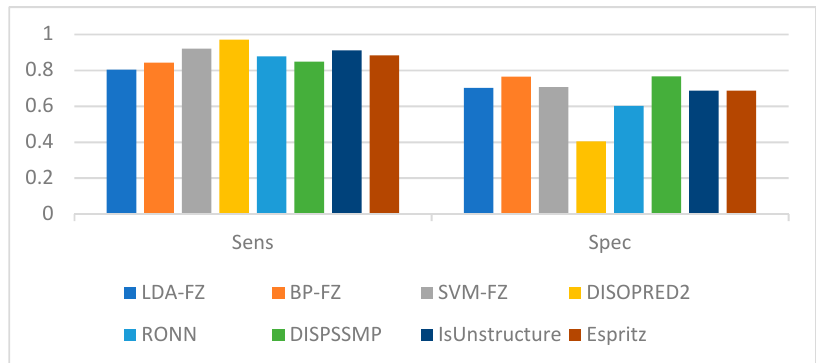
Figure 5. Prediction performance comparison based on test set R80 (Sens, Spec).